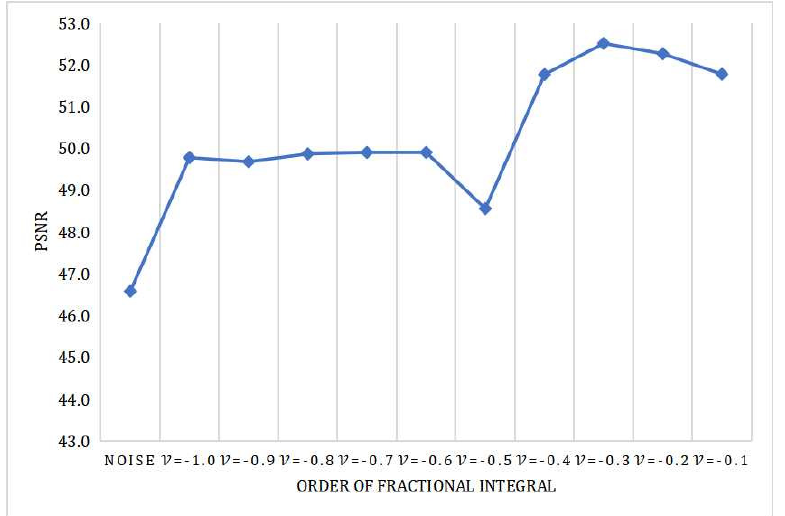
Figure 7. Fractional denoising effect with different orders of the fractional integral (PSNR, dB).